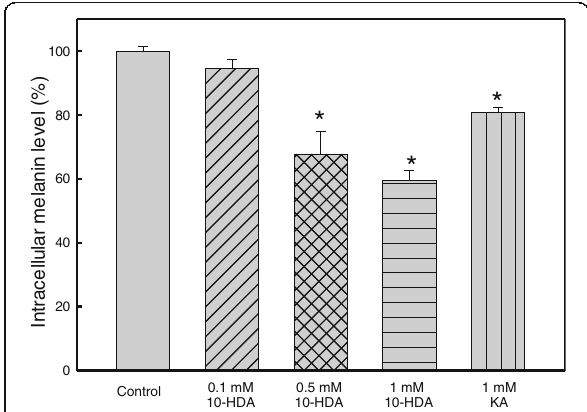
Fig. 2 The inhibitory effect on melanogenesis in B16F1 cells. B16F1 melanoma cells were treated with different concentrations of 10-HDA. Data are presented as mean ± SEM of three independent experiments. * P < 0.05 is considered to be significant